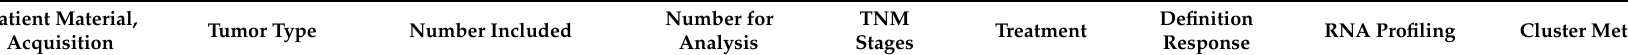
Table 1. Summary of cohorts and methods from studies discussed in Section